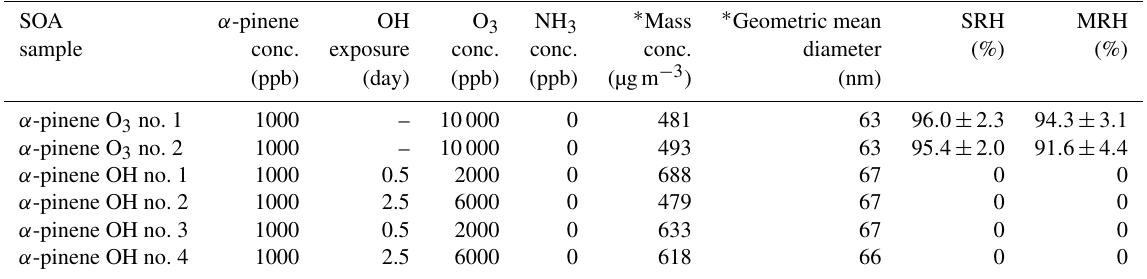
Table 2. Experimental conditions for the production and collection of SOA particles from α -pinene ozone with NH 3 (termed “ α -pinene O 3 / NH 3 ”) and photooxidation with NH 3 (termed “ α -pinene OH/NH 3 ”). The separation relative humidity (SRH) upon moistening and the merging relative humidity (MRH) upon drying are listed. The SRH is the RH at which liquid–liquid phase separation occurred. The MRH is the RH at which two phases merged into one phase. The uncertainties indicate the 2 σ from several humidity cycles for one sample and from the uncertainty of the calibration. SRH and MRH values of zero indicate that LLPS was not observed. SOA α -pinene OH sample conc. exposure conc. (ppb) α -pinene O 3 / NH 3 no. 1 α -pinene O 3 / NH 3 no. 2 1000 α -pinene OH / NH 3 no. 1 α -pinene OH / NH 3 no.